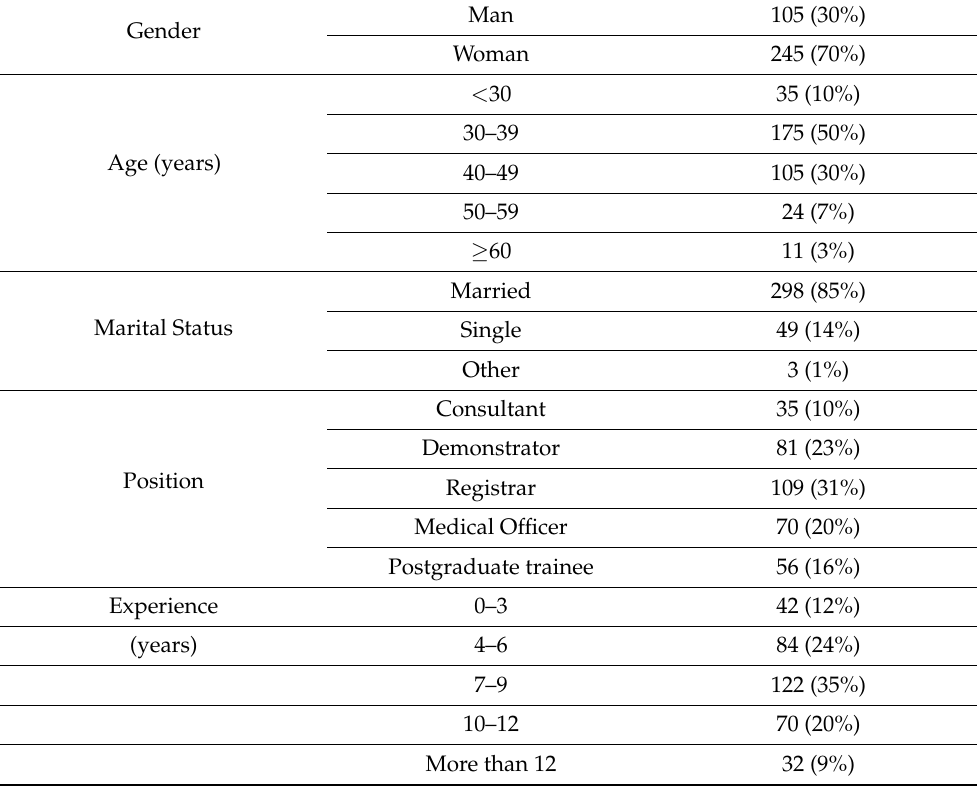
Table 1. Descriptive statistics of the demographic